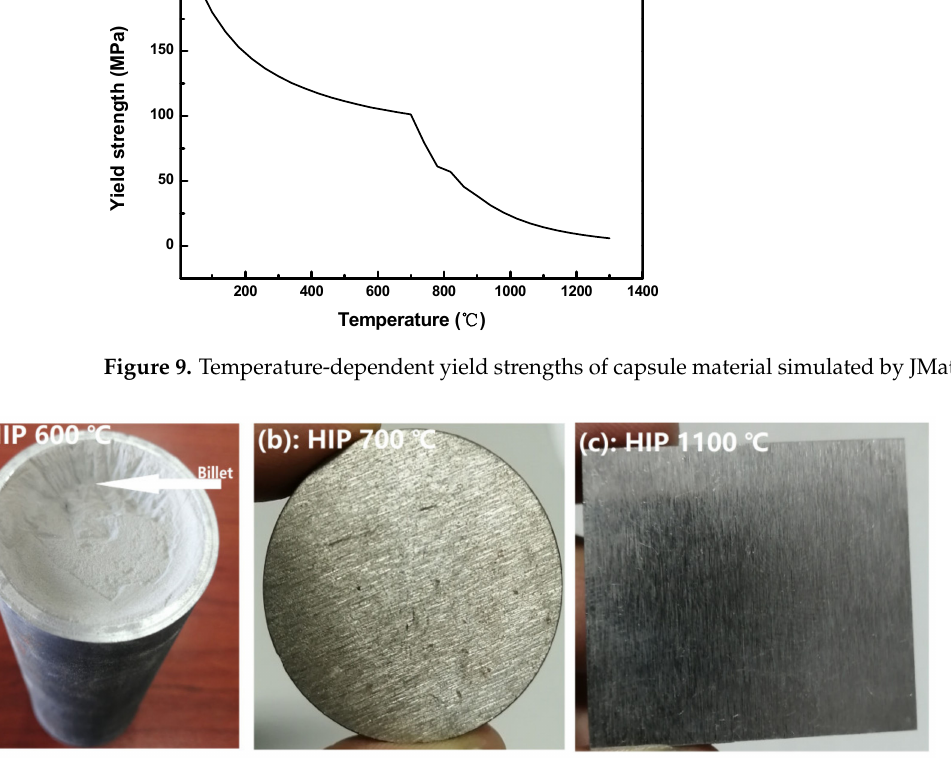
Figure 10. Photographs of samples by HIP at ( a ) 600 ◦ C, ( b ) 700 ◦ C, and ( c ) 1100 ◦